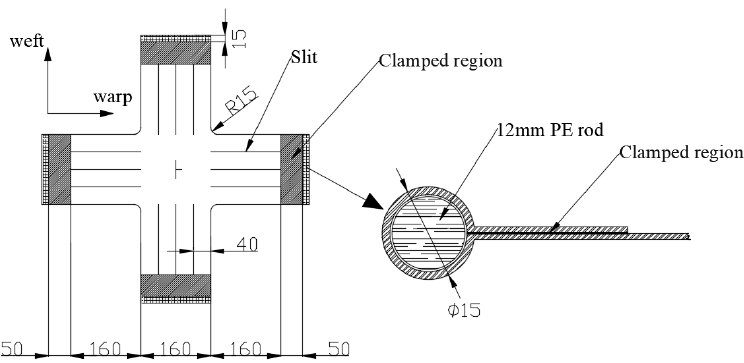
Figure 6. Biaxial specimen (units in millimeters).